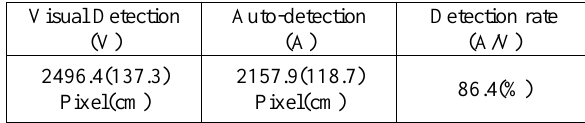
Table 3. Total length of existing and Auto-detected cracks